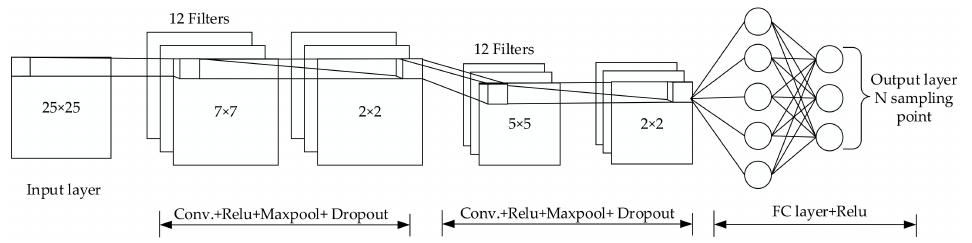
Figure 6. Convolutional neural network (CNN)-based indoor positioning model.